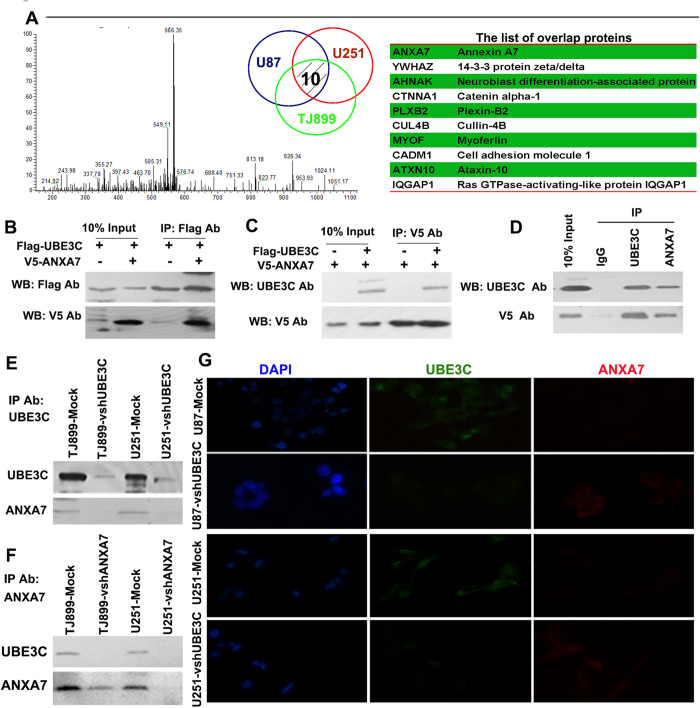
Proteomic Screen identifies UBE3C Interactes with ANXA7 to mediates ANXA7 Ubiquitin degradation Identification of the peptide from the UBE3C associated protein by Mass spectra, and there are ten proteins onerlap in U251, U87 and TJ899 cells, and the overlap protein was listed in the table; (B and C) Lysates of 293T cells transfected with plasmids encoding the Flag-UBE3C or V5-ANXA7 proteins were immunoprecipitated with the indicated antibodies and analyzed by immunoblotting with anti-Flag or V5 antibodies. (D, E and F) Co-IP assays demonstrated that UBE3C forms a complex with ANXA7 in gliomas cells; (G) Localization of UBE3C (green) and ANXA7 (red) in gliomas cells by immunofluorescence (Magnification, × 1,000);.